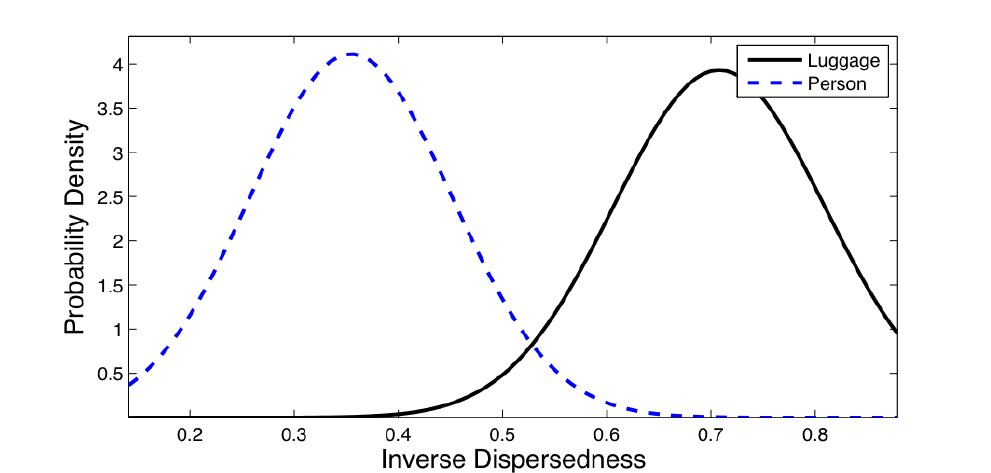
Figure 8. Statistical distributions for Inverse Dispersedness feature in Luggage and Person .